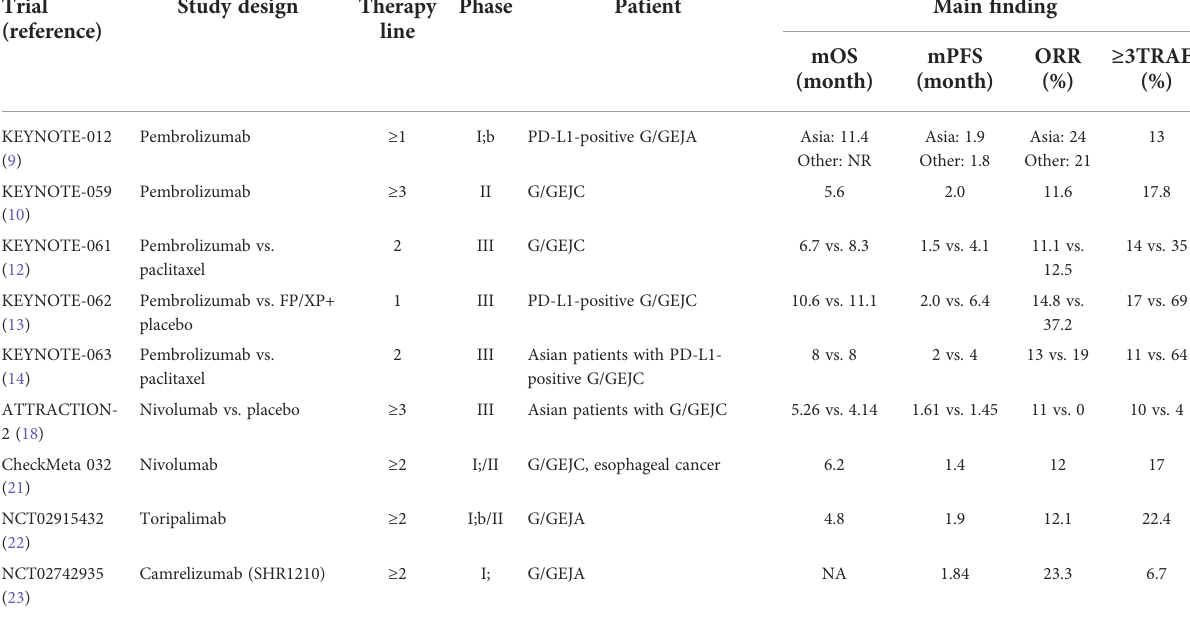
TABLE 1 Clinical trials of PD-1 immune checkpoint inhibitors monotherapy for advanced gastric